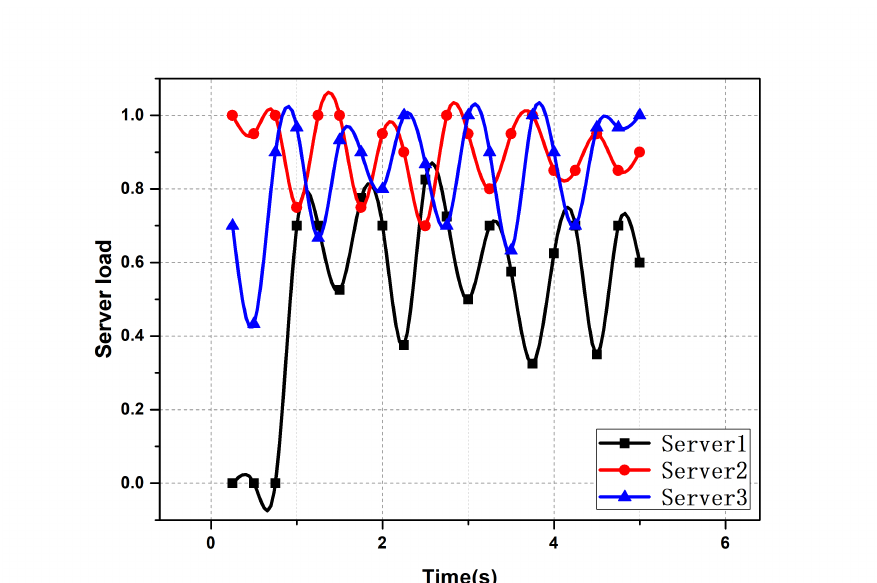
Figure 7. The fluctuation of the server load in the case of server selection based on the polling algorithm.